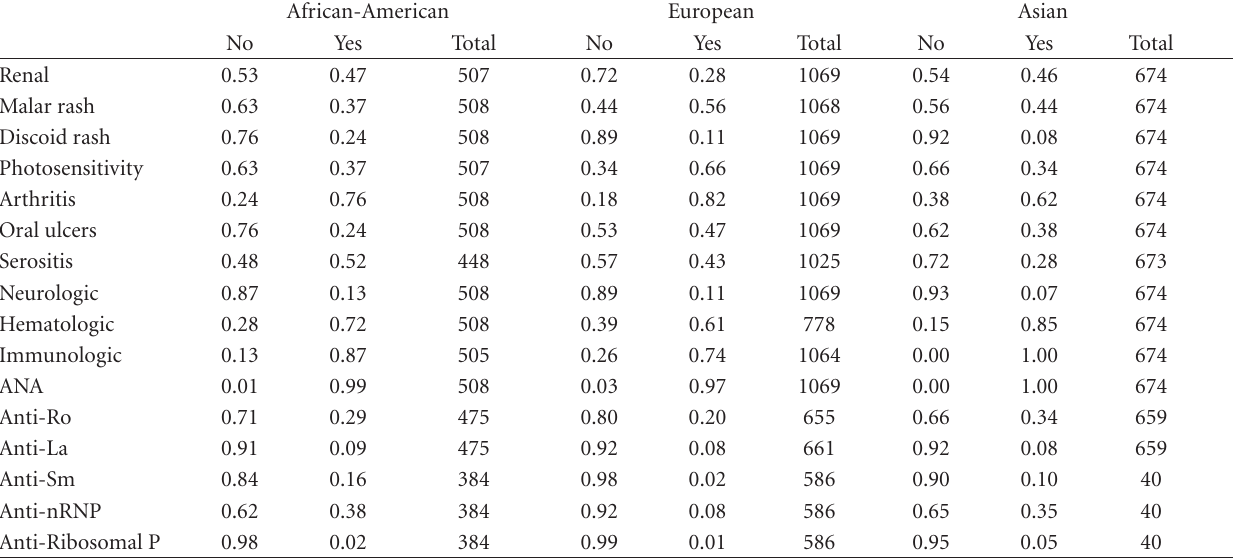
Table 2: Clinical and serologic data for the SLE patients in each ancestral background.